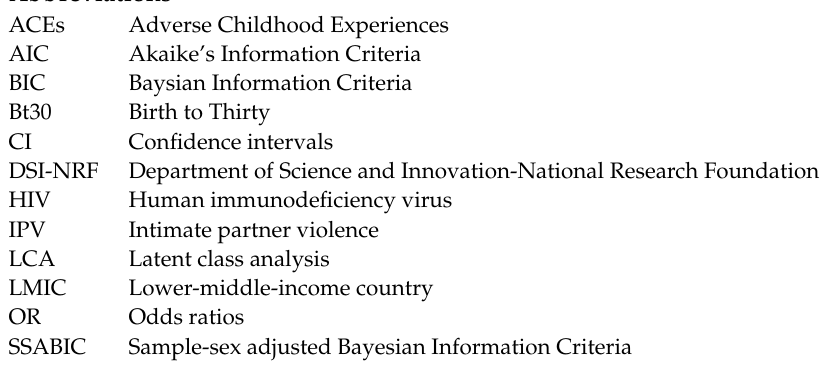
ACEs; Table S3: Crude associations between single, cumulative and clustered prospective ACEs and health and human capital outcomes; Table S4: Crude associations between single, cumulative and clustered retrospective ACEs and health and human capital outcomes; Table S5: Adjusted associations between single, cumulative and clustered prospective ACEs and health and human capital outcomes; Table S6: Adjusted associations between single, cumulative and clustered retrospective ACEs and health and human capital outcomes; Table S7: Adjusted associations between single, cumulative and clustered prospective ACEs and health and human capital outcomes, by sex; Table S8: Adjusted associations between single, cumulative and clustered retrospective ACEs and health and human capital outcomes, by